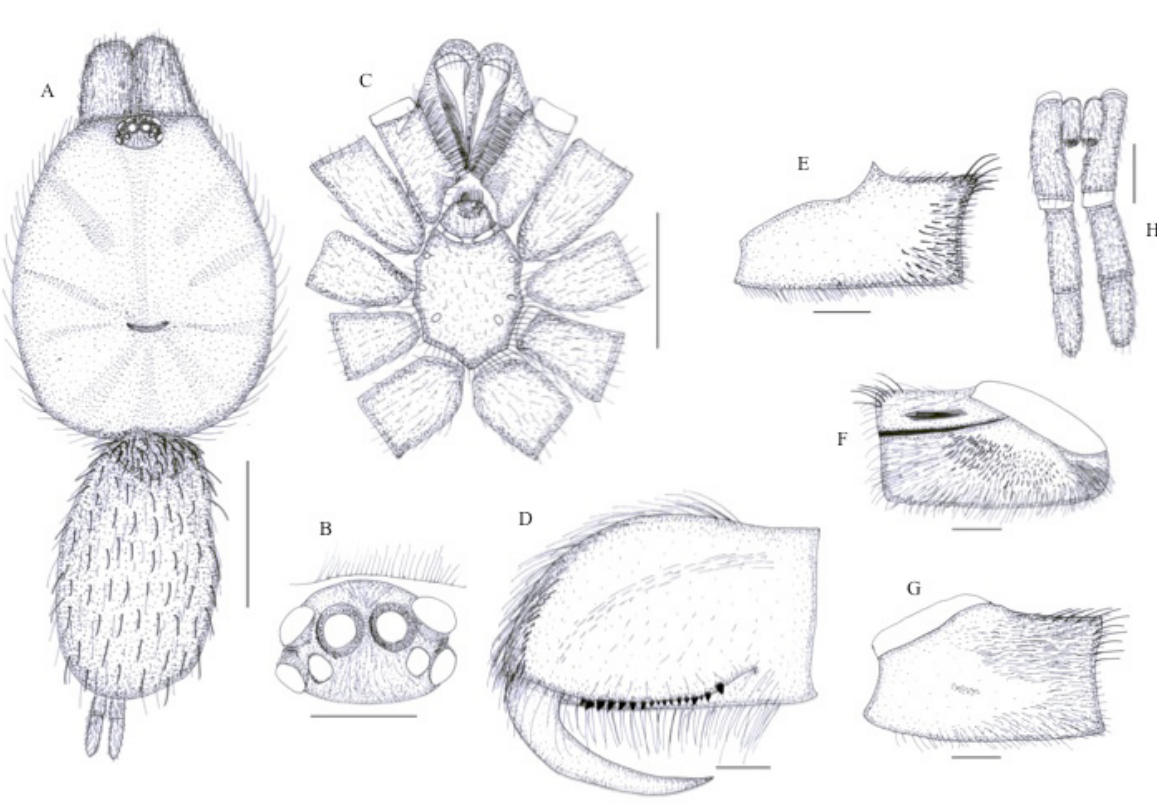
Figure 5. Neoheterophrictus sahyadri sp. nov., male (WILD-10-ARA-579). A - Carapace and abdomen dorsal view; B - Eye; C - Sternum, maxillae, labium, chelicerae; D - Chelicerae prolateral view; E - Maxillae, retrolateral view; F - Coxa I, prolateral view; G - Coxa I, retrolateral view; H - Spinnerets. Scale 1.0mm for B, D–H and scale 0.5mm for A,